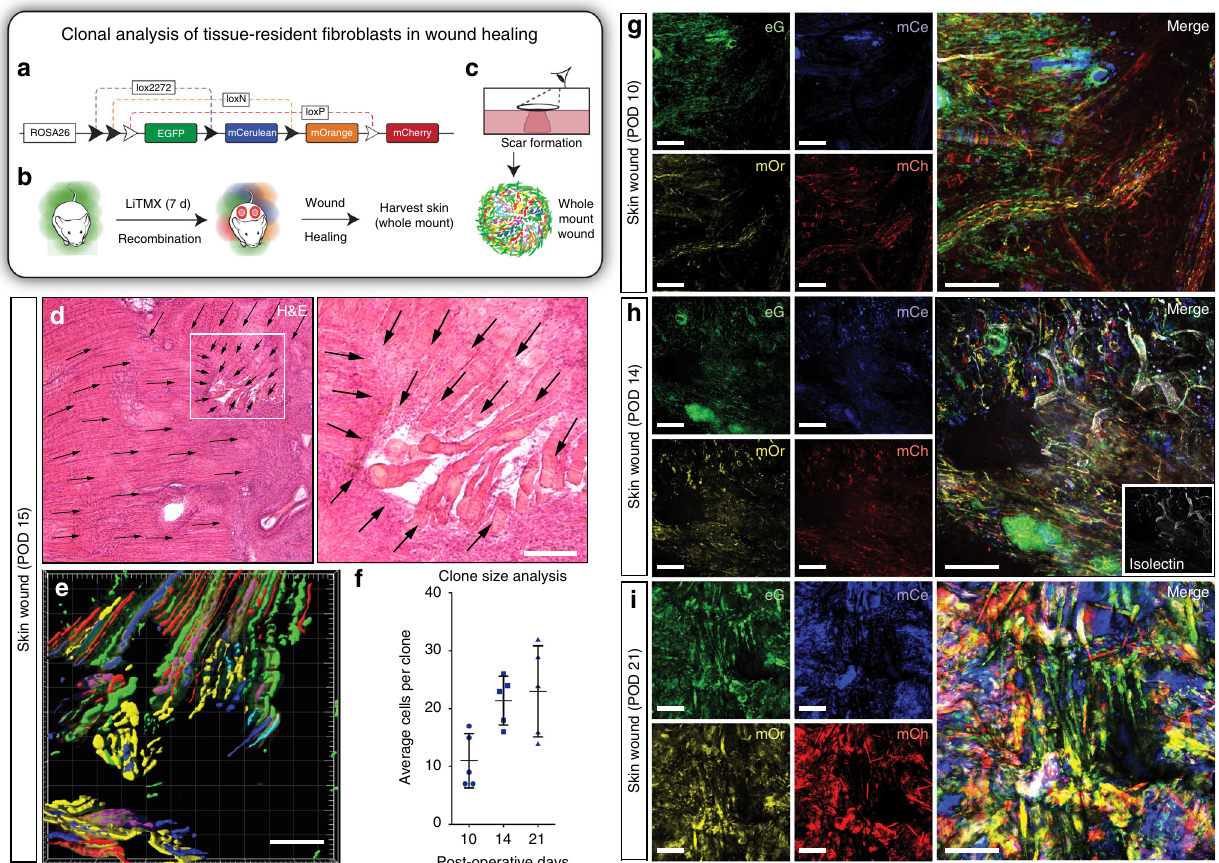
Fig. 3 LiTMX application in Rainbow mice for clonal analysis in wound healing. a Schematic of Cre-mediated recombination and resultant cellular color code change in Rainbow mice. b Schematic shows splinted, full-thickness excisional skin wounds with local application of LiTMX. c Healing cutaneous wounds are excised, whole mounted and 3D confocal imaging is conducted. d A ×10 magni fi cation of H&E staining of a dorsal wound on cross-section (left), white solid box magni fi ed at ×20 reveals linear migration of cells involved in wound healing (right) (black arrows indicate direction of cell migration). e Whole-mount wound at POD 15 visualized using Imaris software shows linear migration from the wound edge towards the center of fl uorescent-labeled clones of cells involved in wound healing. f The average number of cells per clone increases with time post-wounding (data quanti fi ed from g – i , n = 5 replicates per timepoint, error bars indicate SD). g After local LiTMX dosing at time of cutaneous wounding in Rainbow mice, confocal imaging of whole- mount specimens shows clonal outgrowth of tissue-resident (non-circulating) wound-responsive cells at POD 10. (eG = eGFP, mCe = mCerulean, mOr = mOrange, and mCh = mCherry, individual channels at left, merged images at right). h Clone size increases at POD 14 (white staining, inset, indicates isolectin staining to highlight vasculature). i Clone size continues to increase during remodeling after the wound is healed, at POD 21. Experiments conducted with n = 3 replicates per timepoint (where applicable) per condition (unless otherwise indicated), 2 dorsal wounds per mouse, scale bars represent 200 μ m (unless otherwise Topical application of LiTMX to unwounded mouse skin . Adult mTmG ( Actin- CreER T2 :: Rosa26-mTmG , α SMA-CreER T2 :: Rosa26-mTmG , and PDGFR α -CreER T2 :: Rosa26-mTmG ) and Rainbow ( Actin-CreER T2 :: Rosa26-VT2/GK3 ) mice were anesthetized with 2% inhaled Iso fl urane (Henry Schein, Melville, NY) and 30mg/ hair clippers followed by depilatory cream (Nair ™ , Church & Dwight Co., Ewing, NJ). Silicone, 12-mm diameter washers (Invitrogen) were secured around the perimeter of the regions of interest with cyanoacrylate glue and interrupted 6-0 nylon sutures (Ethilon ® , Inc., Somerville, NJ, purchased from eSutures.com, Mokena, IL) to adhere the washers to the skin. LiTMX (20 μ g, unless otherwise speci fi ed) was delivered topically to each of the 4 quadrants (1 μ l per quadrant) at the inner diameter of the ring using a 5 μ l Hamilton syringe (Hamilton Company, Reno, NV), for a course of 2 days. After 10 min, a sterile Tegaderm dressing (3M Healthcare, St Paul, MN) was applied to the area to protect the skin within the ring. Animals were euthanized and intact skin was harvested 1 week after induction. Application to splinted full-thickness excisional wounds . Adult mTmG ( Actin- LiTMX (20 μ g, unless otherwise speci fi ed) was delivered topically to the fat pad CreER T2 :: Rosa26-mTmG, α SMA-CreER T2 :: Rosa26-mTmG , and PDGFR α -CreER T2 :: bilaterally, single dose only. The peritoneum was closed with running 4-0 monocryl Rosa26-mTmG ) and Rainbow ( Actin-CreER T2 :: Rosa26-VT2/GK3 ) mice were and horizontal mattress suture using 6-0 nylon was used to close the skin. anesthetized and hair on the dorsal skin was removed as previously described 9 . The